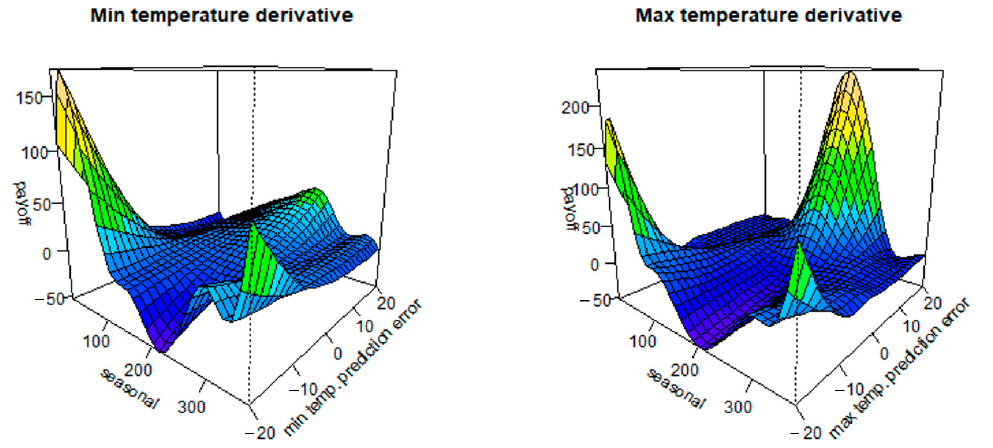
Figure 3. Estimated temperature derivatives’ payoffs in the product model (12).